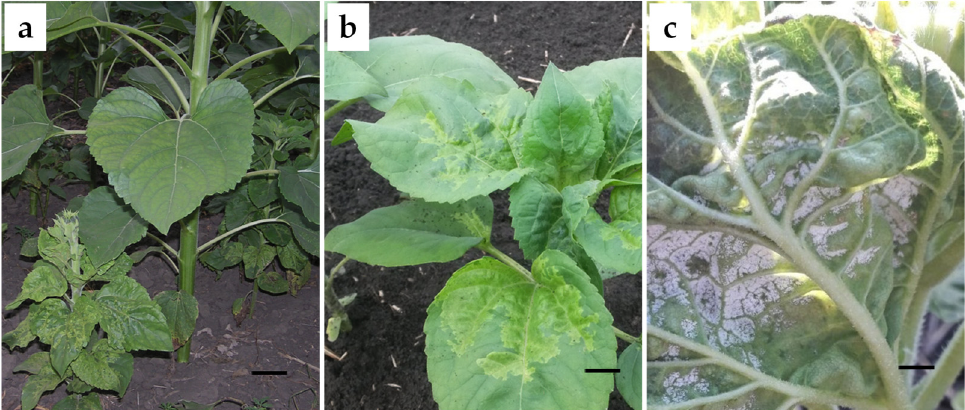
Figure 1. Symptoms and signs of sunflower downy mildew. ( a ) Dwarfing of the diseased plants (Photo: R. Bán); ( b ) leaf chlorosis along the veins (Photo: Z. Pálinkás); and ( c ) white coating (sporangiophores and sporangia) on the back of the leaf (Photo: K. Körösi). Scale bars represent 10 cm ( a ), 2.4 cm ( b ), and 1.25 cm ( c ).